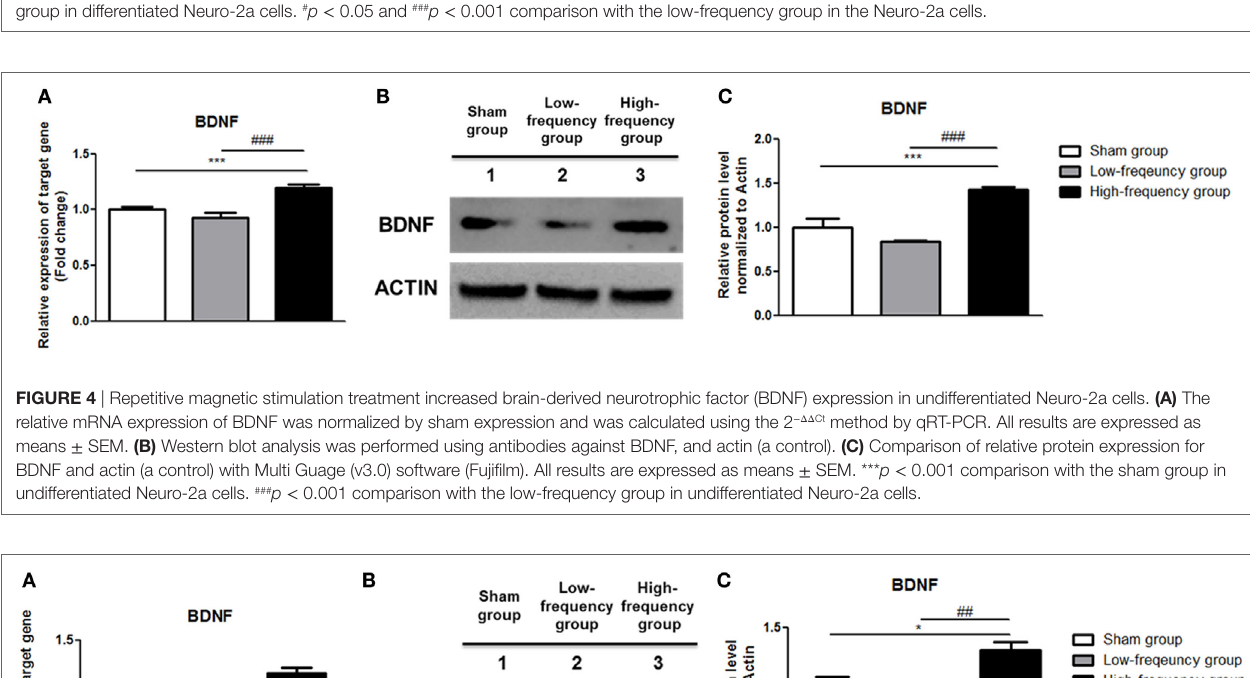
FigUre 3 | Validation of mRNA expression and protein quantification using qRT-PCR and western blot analysis in differentiated Neuro-2a cells. (a) The relative expression of target genes was normalized by sham expression and was calculated using the 2 −ΔΔ Ct method by qRT-PCR during neuronal differentiation of Neuro-2a cells. (B) Western blot analysis was performed with calmodulin-dependent protein kinase II (CaMKII), phospho-cAMP response element binding (p-CREB), and actin (as a control) antibodies in the Neuro-2a cells. (c) Comparison of relative protein expression for CaMKII, p-CREB, and actin (a control) in differentiated Neuro-2a cells using Multi Guage (v3.0) software (Fujifilm). All results are expressed as means ± SEM. * p < 0.05, ** p < 0.01, and *** p < 0.001 comparison with the sham group in differentiated Neuro-2a cells. # p < 0.05 and ### p < 0.001 comparison with the low-frequency group in the Neuro-2a